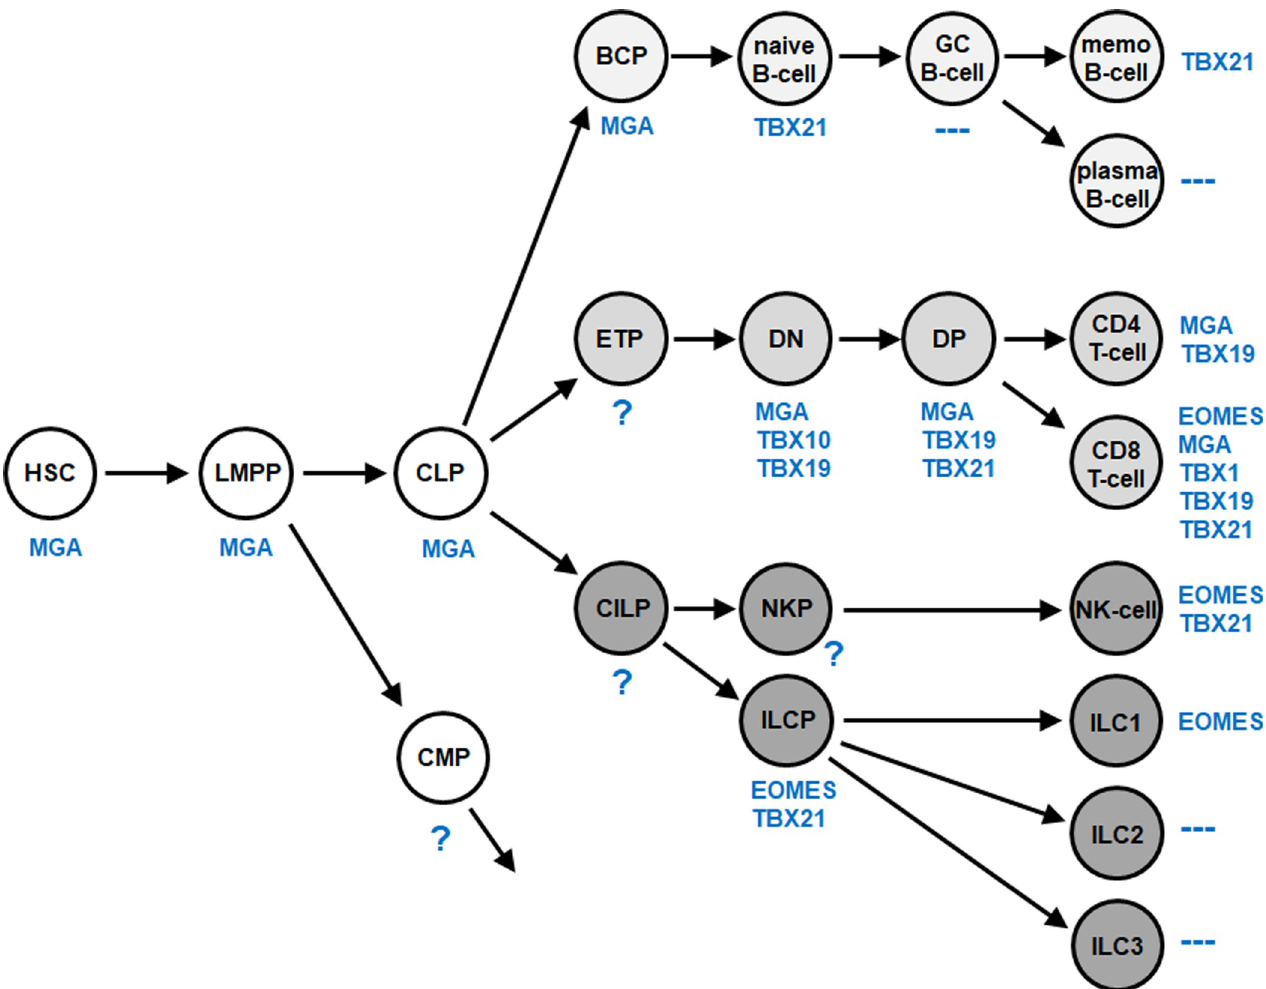
Fig 1. Lymphoid TBX-code. This diagram summarizes screening results for T-box gene expression (blue) in early hematopoiesis and lymphopoiesis. We termed this expression pattern TBX-code. Of note, TBX3 is not expressed in these hematopoietic entities. BCP: B-cell progenitor, CILP: Common innate lymphoid progenitor, CLP: Common lymphoid progenitor, CMP: Common myeloid progenitor, DN: Double negative T-cell, DP: Double positive T-cell, ETP: Early T-cell progenitor, GC: Germinal center, HSC: Hematopoietic stem cell, ILC: Innate lymphoid cell, ILCP: Innate lymphoid cell progenitor, LMPP: Lymphoid and myeloid primed progenitor, memo: Memory, NKP: NK-cell progenitor.